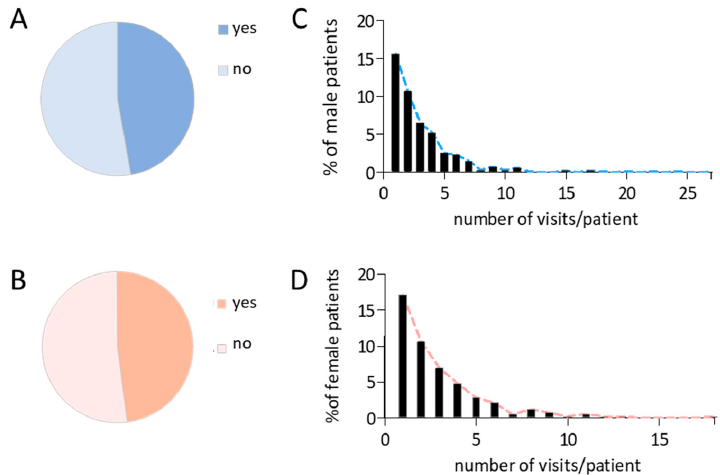
Figure 2. Healthcare utilization within the analyzed refugee cohort. ( A , B ) Proportion of male and female probands seeking help (yes) or not (no) in the medical ward. ( C , D ) visit number distribution in male and female patients [HCU: healthcare utilization].